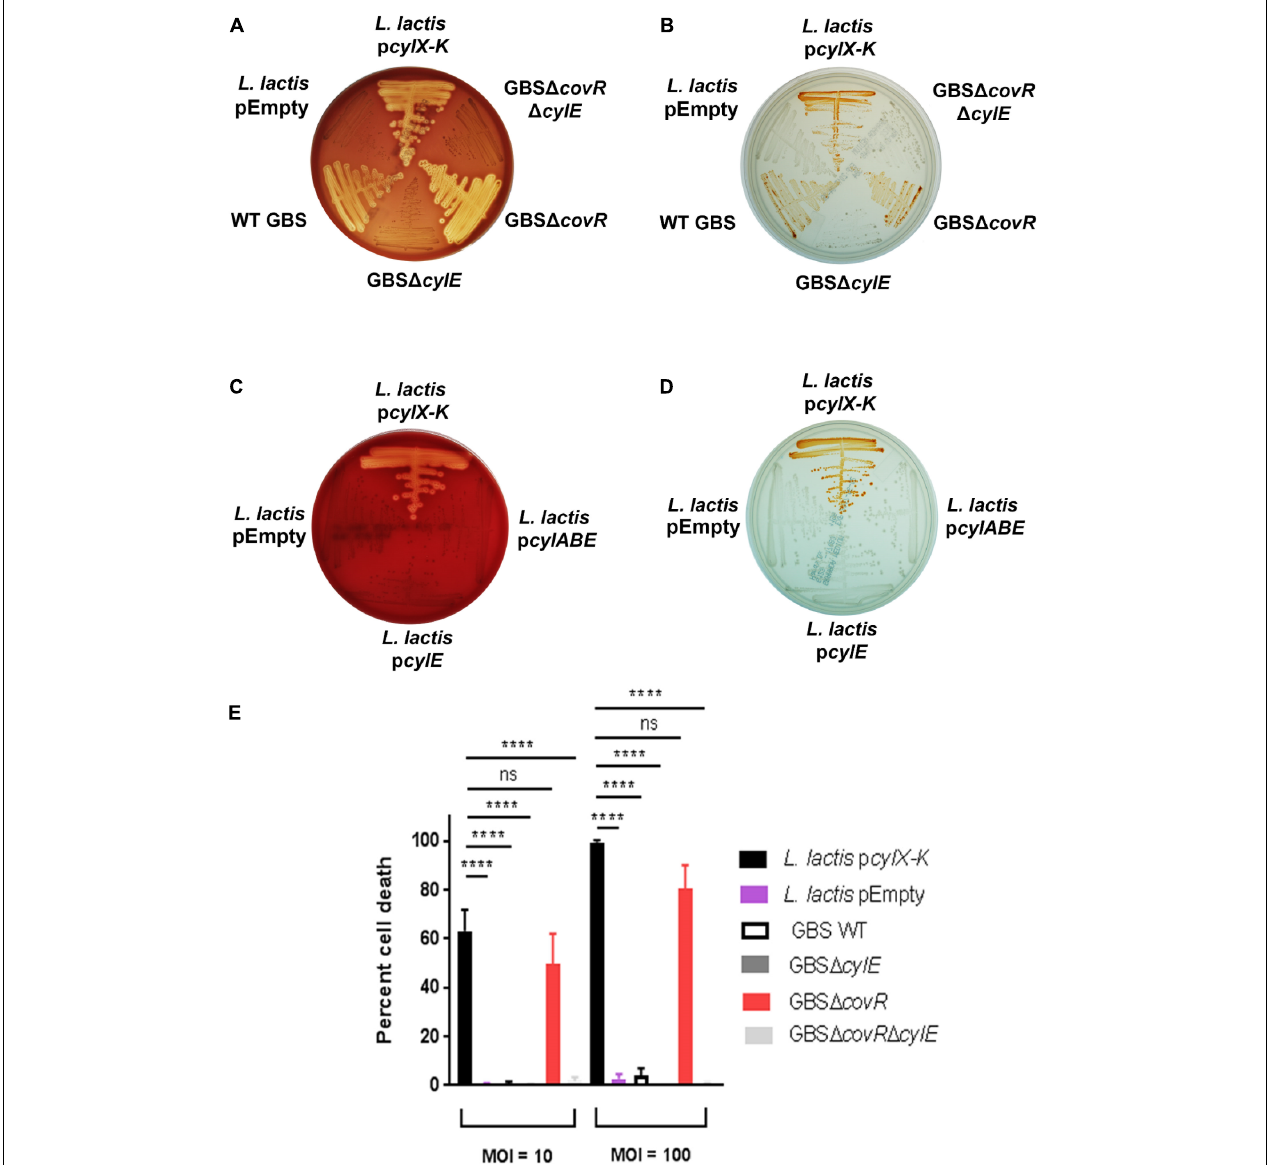
FIGURE 1 | Complementation of L. lactis with pcylX-K, but not empty plasmid vector, pEmpty, conferred hemolysis (A) and pigmentation (B) similar to that observed for hemolytic GBS, including strains that lack the transcriptional repressor of the cyl operon, CovR (GBS (cid:49) covR ). Of note, GBS strains lacking CylE (i.e., GBS (cid:49) cylE , GBS (cid:49) covR (cid:49) cylE ) are neither hemolytic nor pigmented. Complementation of L. lactis with cylE alone or cylA , cylB , and cylE did not confer hemolysis (C) or pigmentation (D) to L. lactis . (E) L. lactis p cylX-K, L. lactis pEmpty, GBS WT, GBS (cid:49) cylE , GBS (cid:49) covR , or GBS (cid:49) covR (cid:49) cylE were incubated with human neutrophils for 4 h at an MOI of 10 and 100, and neutrophil death was measured by LDH release into cell supernatants relative to Triton X-100 and PBS-only controls. Mean and standard error from three independent experiments performed in triplicate are shown. One-way ANOVA with Tukey’s post-test was performed. ∗∗∗∗ indicates p < 0.0001, and ns indicates not significant, or p ≥